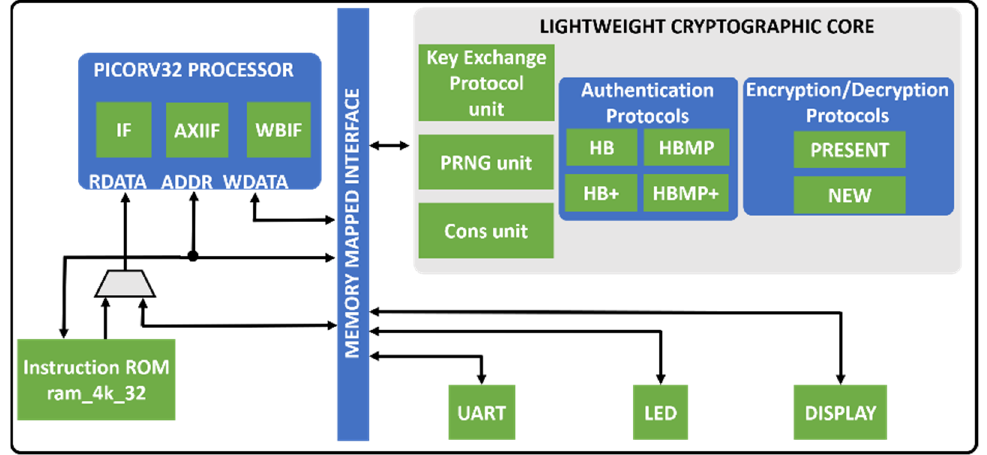
Figure 18. Overall hardware architecture for the proposed lightweight cryptographic